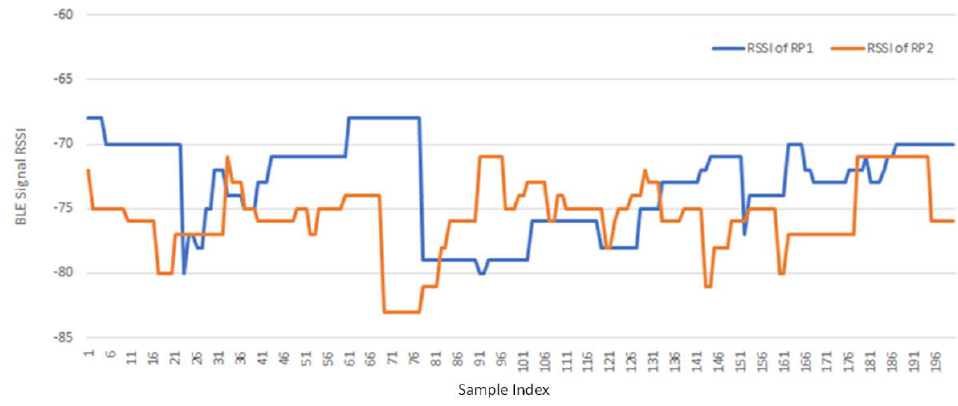
Figure 7. Partial fingerprint data of 200 samples recorded at two RPs for a BN.